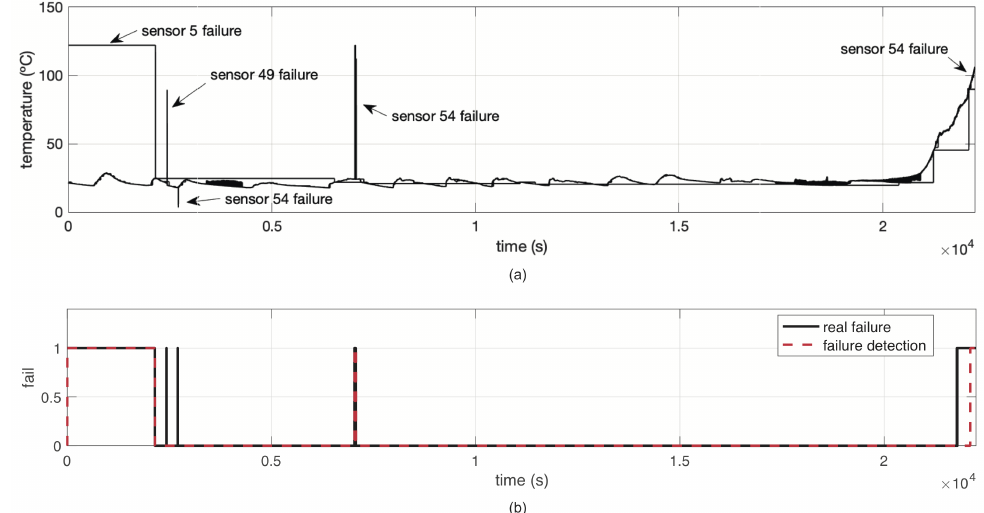
Figure 12. ( a ) Sensor failures in testing data and ( b ) failure detection response in the Intel Lab WSN with N = 54 sensor